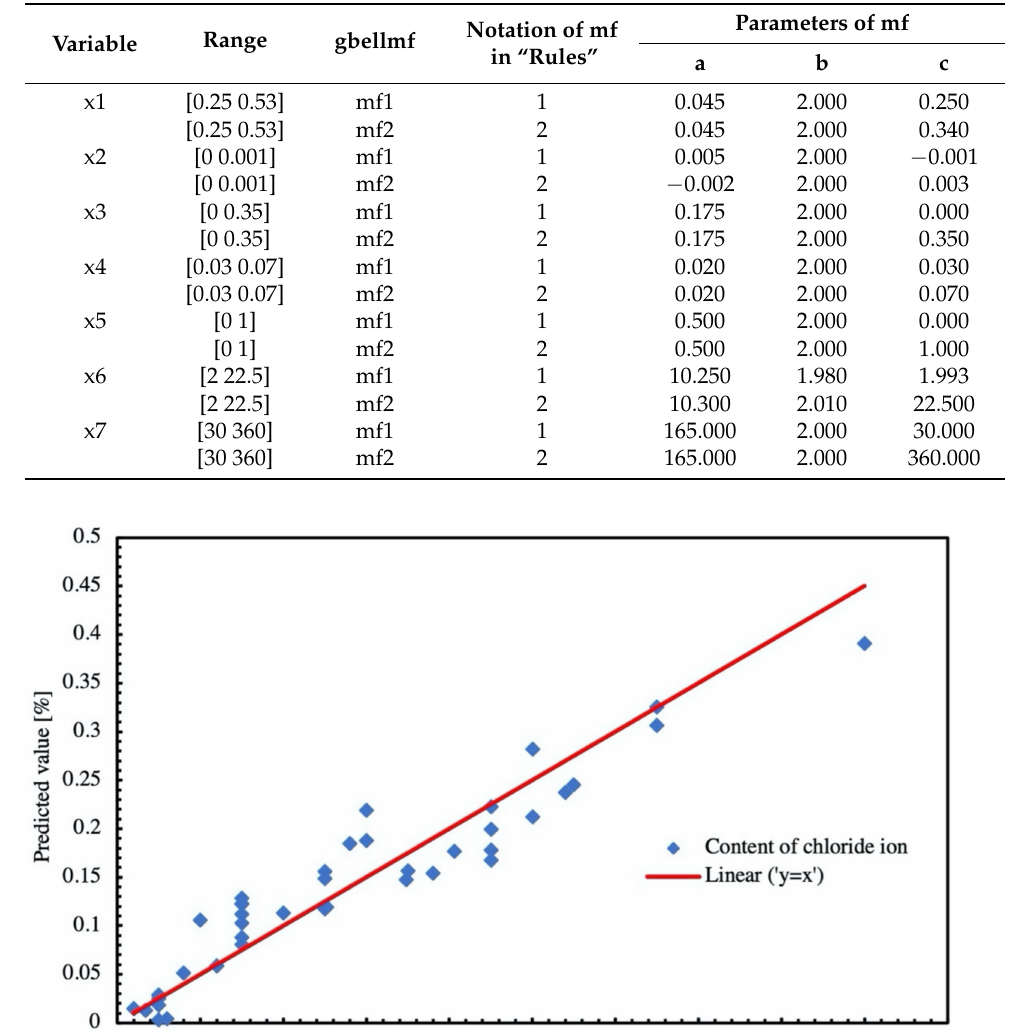
Table 10. Membership functions and parameters—gbellmf.